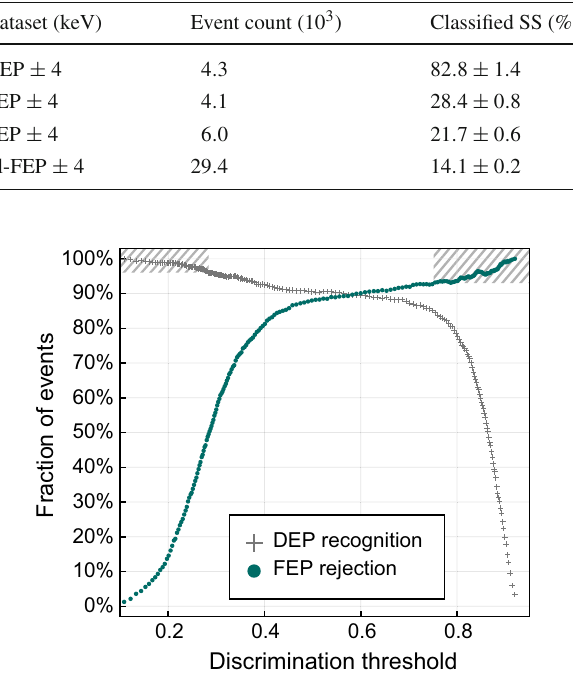
Table 2 Classification of events in the test datasets. The class assign- ment is based on the output, c , of the combined encoder+classifier net- work. Events are counted as SS if c > 0 . 6 (maximum class separation threshold). The given uncertainties are statistical only